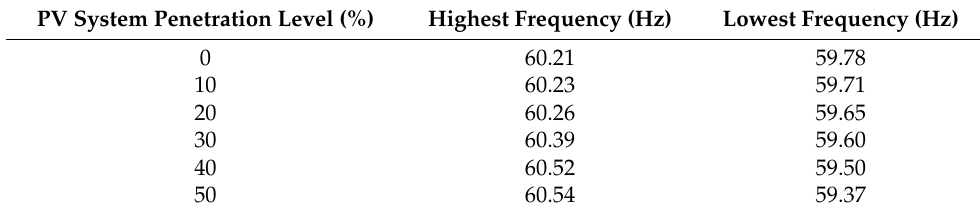
Figure 15. Grid’s frequency (Hz) stability representation throughout the year without the inclusion of the PV system. Table 4. Overall assessment of the grid’s frequency stability due to integrating the PV system, without applying the grid constraints on the PV